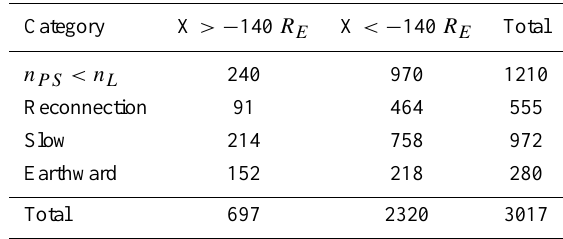
Table 8. Distribution of plasma sheet encounters with respect to Table 9. Relative differences from expected values with respect to X GSE : earthward flows are significantly more likely to be observed